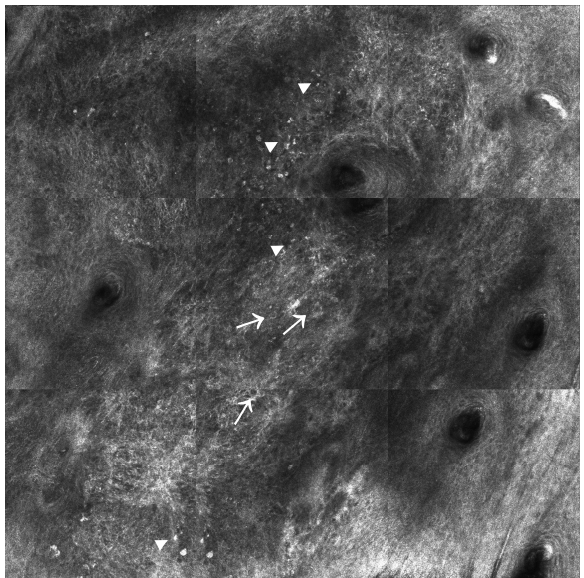
Figure 2. Squamous cell carcinoma. RCM mosaic (1500 × 1500 µm 2 ) showing atypical honeycomb pattern with broadened and irregular intercellular connections, pleomorphic keratinocytes, varying in size and shape and areas of total architectural disarray; scarce large, round, nucleated cells representing dyskeratotic cells (white arrows) and scattered small, bright inflammatory cells (white arrowheads).